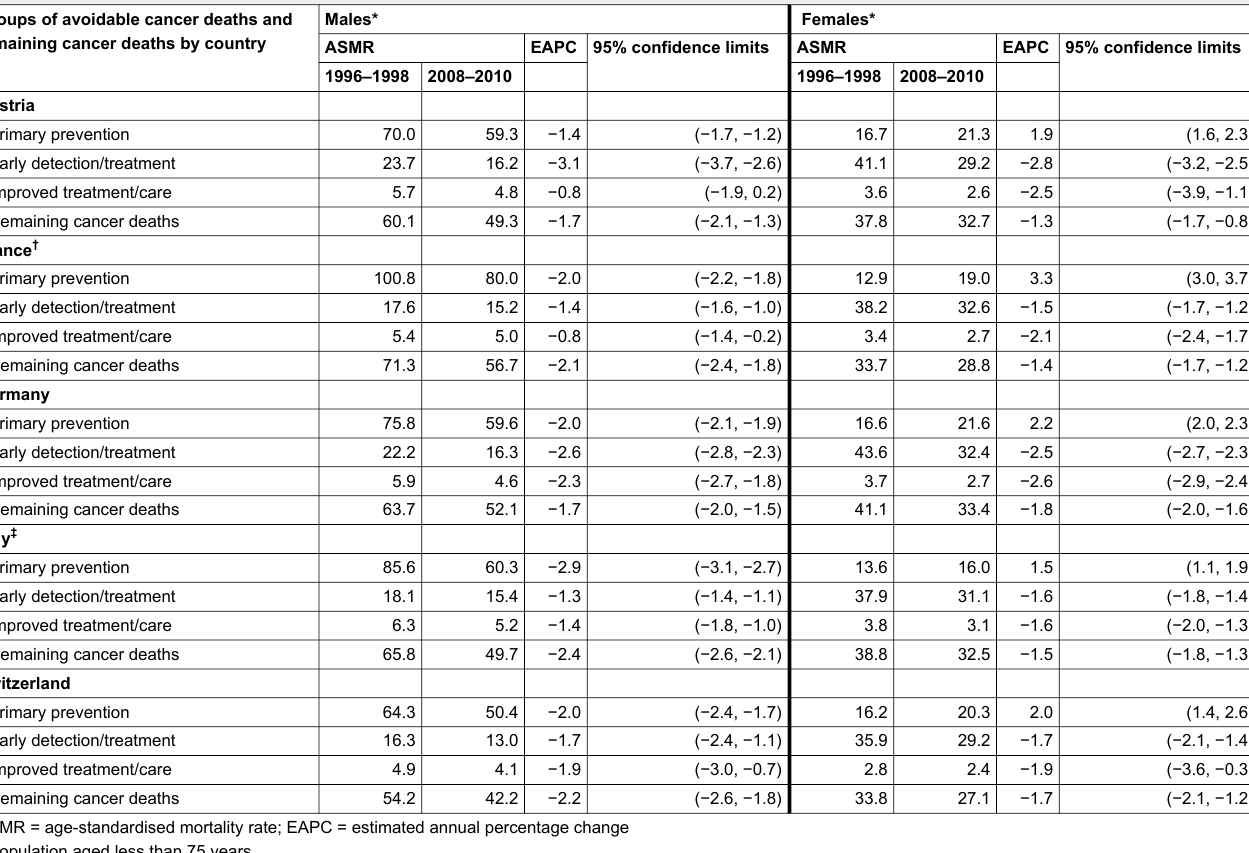
Males* Females* ASMR EAPC